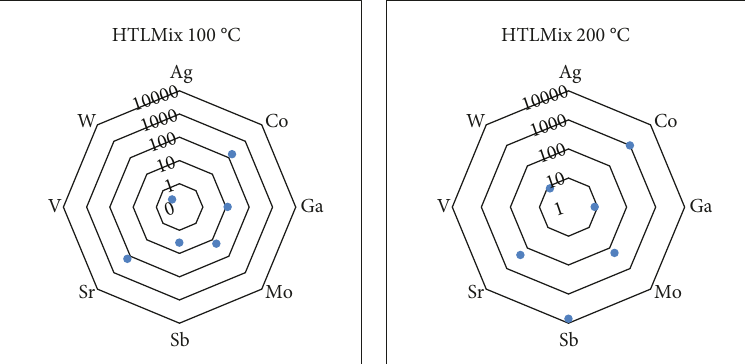
Figure 11: Elemental composition (in ppm) of HTLMix reacted with the mixture of 0.1M HCl and 0.03M HNO temperature under 200bar pressure in Ti batch reactors after 770 hours and 530 hours, respectively.